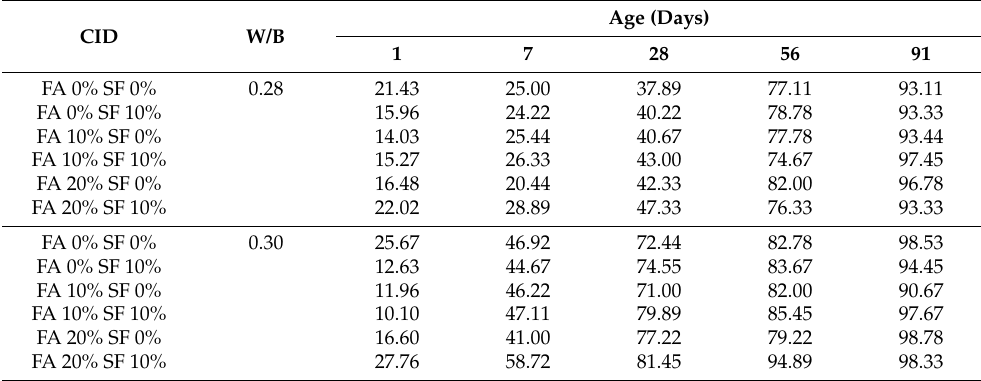
Table A3. Source data for tests on sheet resistance (unit: k Ω -cm).